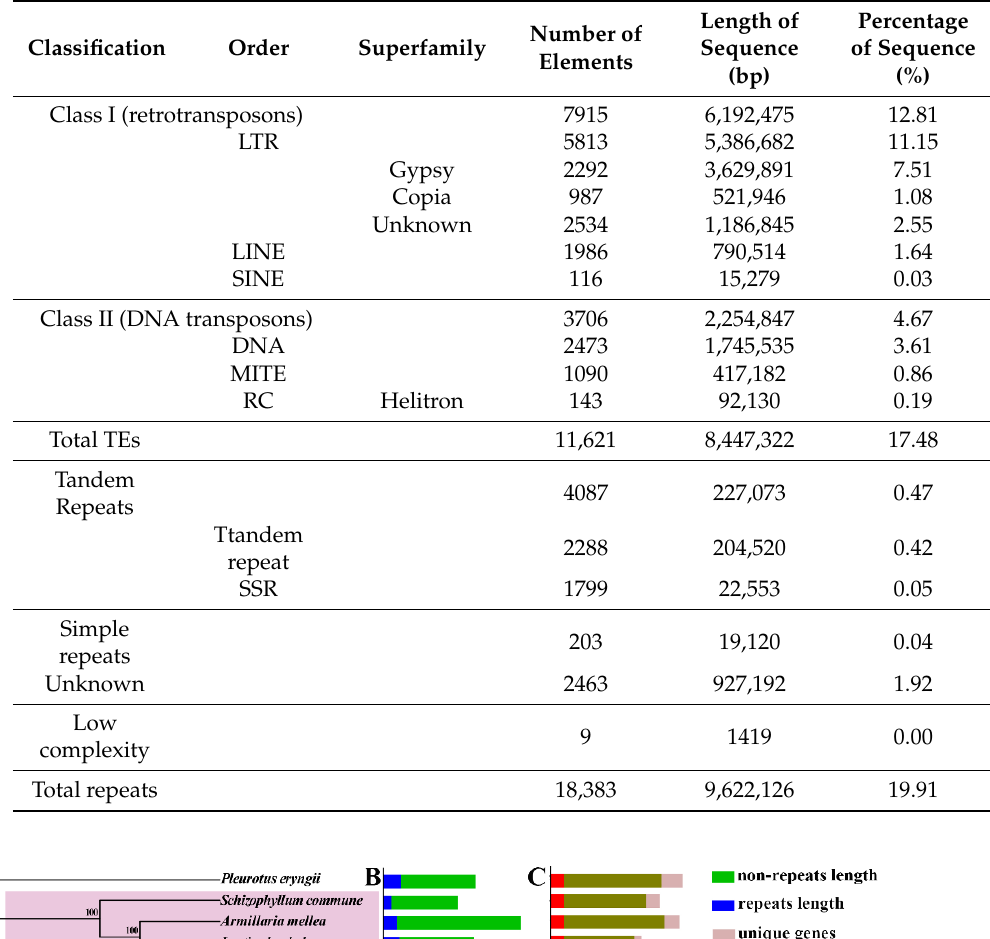
Table 2. Classification of the repeat sequences in the genome of Stropharia rugosoannulata .